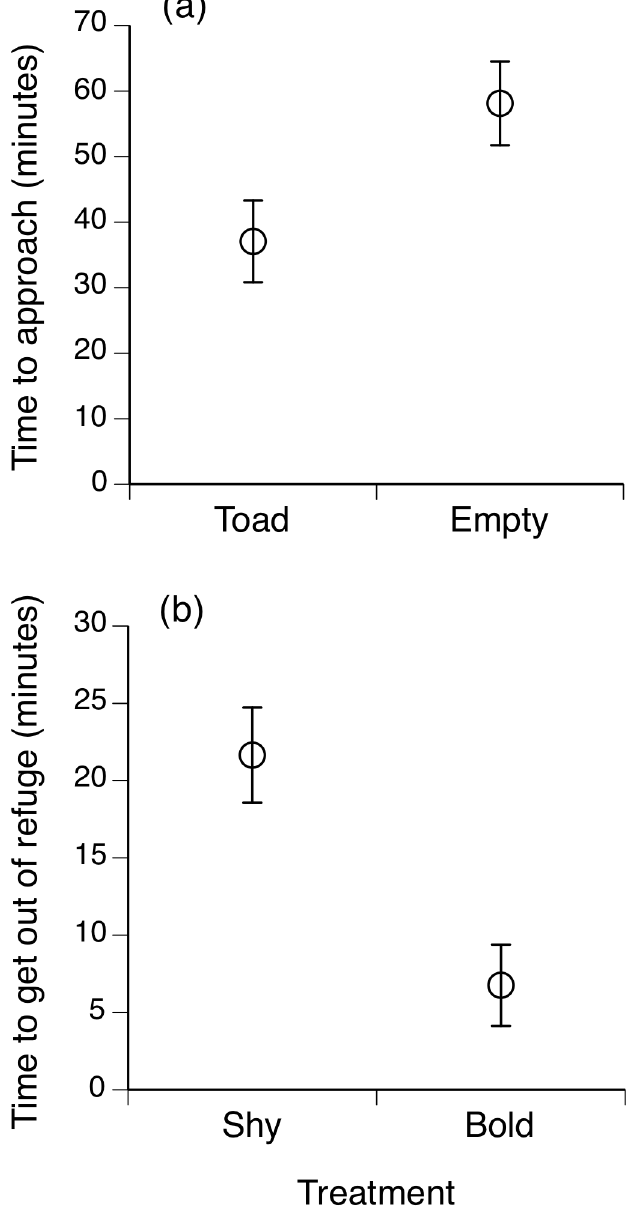
Figure 2. Behavioural divergence within cane toads. The upper panel shows the mean time taken for a free-ranging toad to approach an experimental feeding station and begin feeding, as a function of whether or not the station included an already-feeding conspecific toad. The lower panel shows the time taken for toads to exit from shelter items in laboratory trials. The two groups of toads compared in this panel are ‘bold’ and ‘shy’ animals, as categorized from their responses to experimental feeding stations in field trials conducted on the previous night. ‘Bold’ toads are those that approached an empty feeding station (asocial), whereas ‘shy’ toads are those that approached a feeding station containing a conspecific (social). The graphs show mean values and associated standard errors.